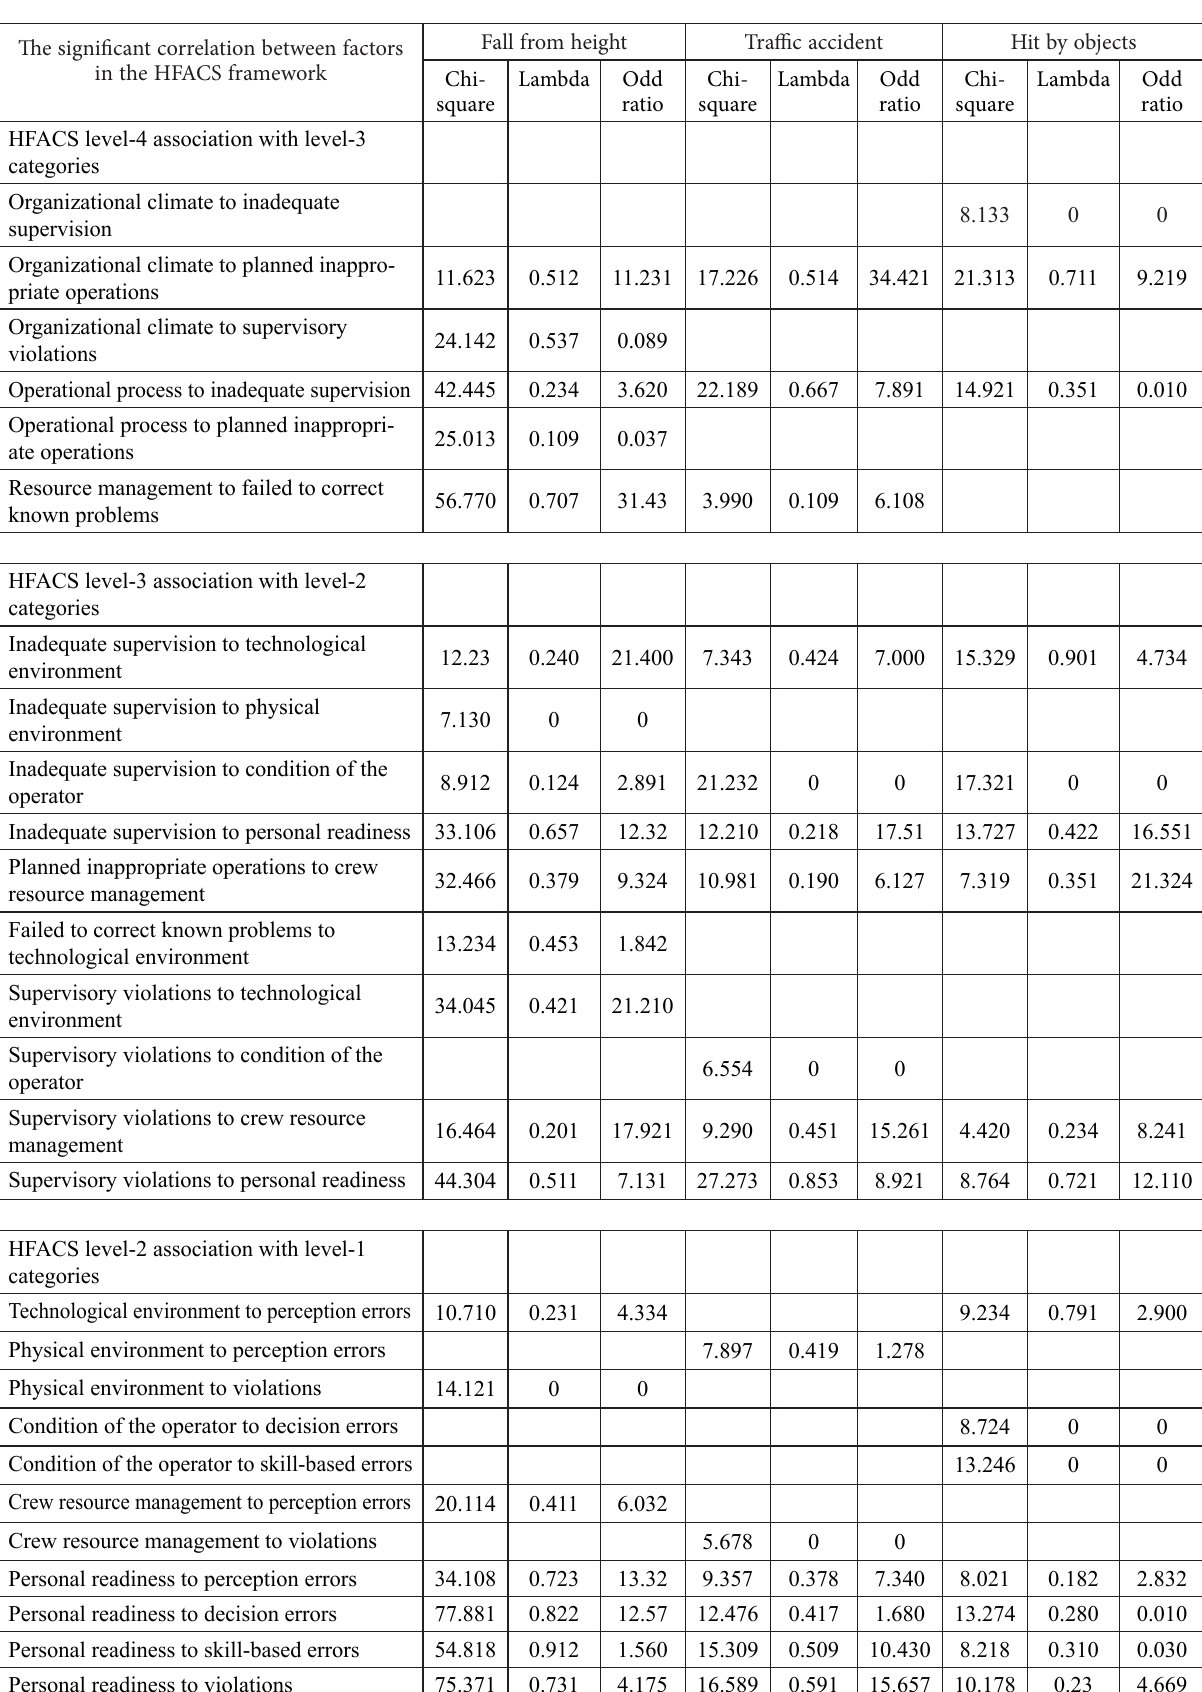
Table 10. The results of relevancy